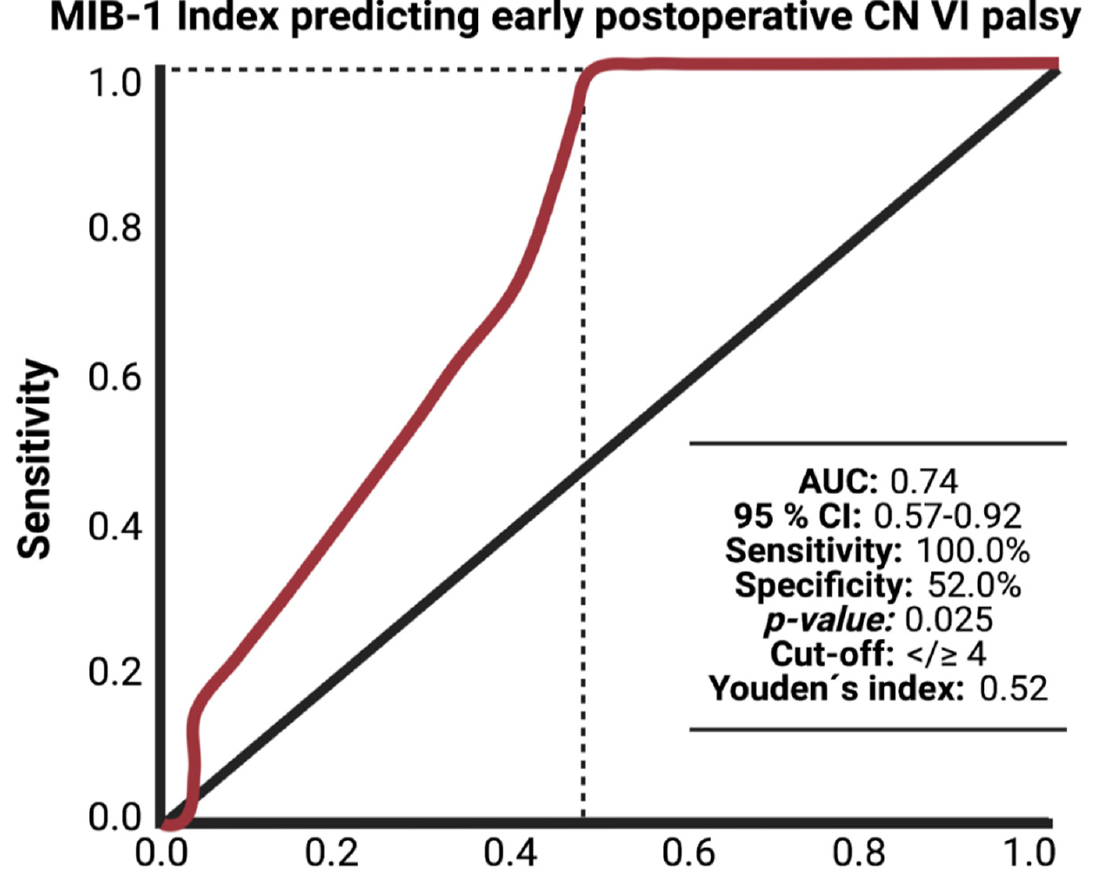
Figure 3. Receiver-operating characteristic curve (ROC) illustrating the ability of the MIB-1 index in the association with new postoperative abducens nerve deficits after surgery for primary sporadic petroclival meningioma via the retrosigmoid approach.